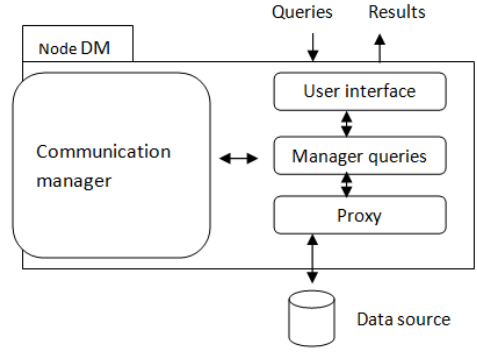
Figure 1. DM node